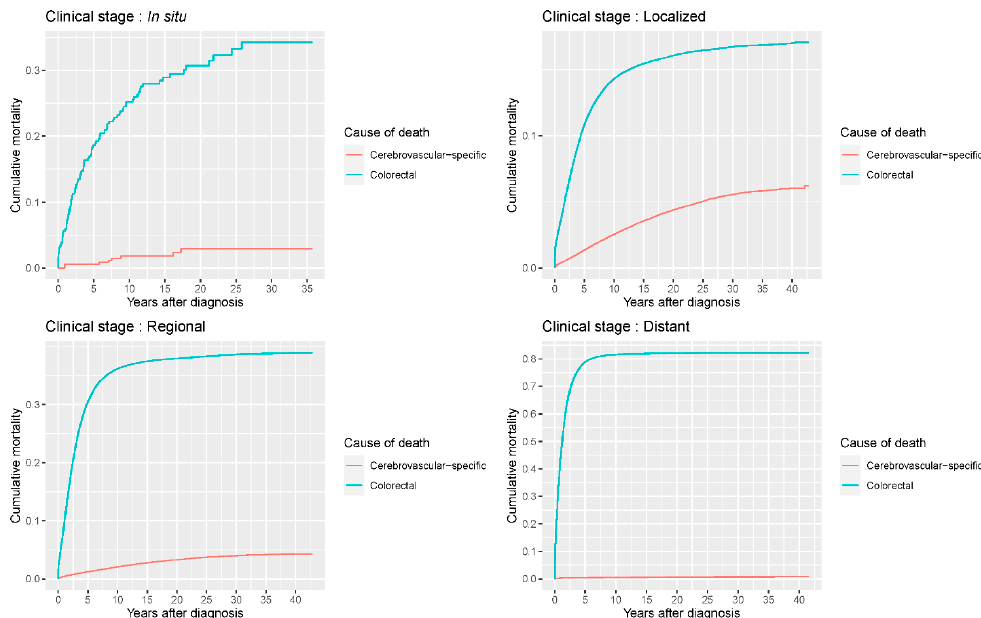
Figure 7. Cumulative cerebrovascular-specific and colorectal cancer-specific mortality stratified by tumor stage. Univariate analyses using a competing risk model were performed to assess the relationship between tumor clinical stage and CVSM in CRC patients ( p < 0.0001), and differences in cumulative mortality among different subgroups were analyzed by Gary’s test.